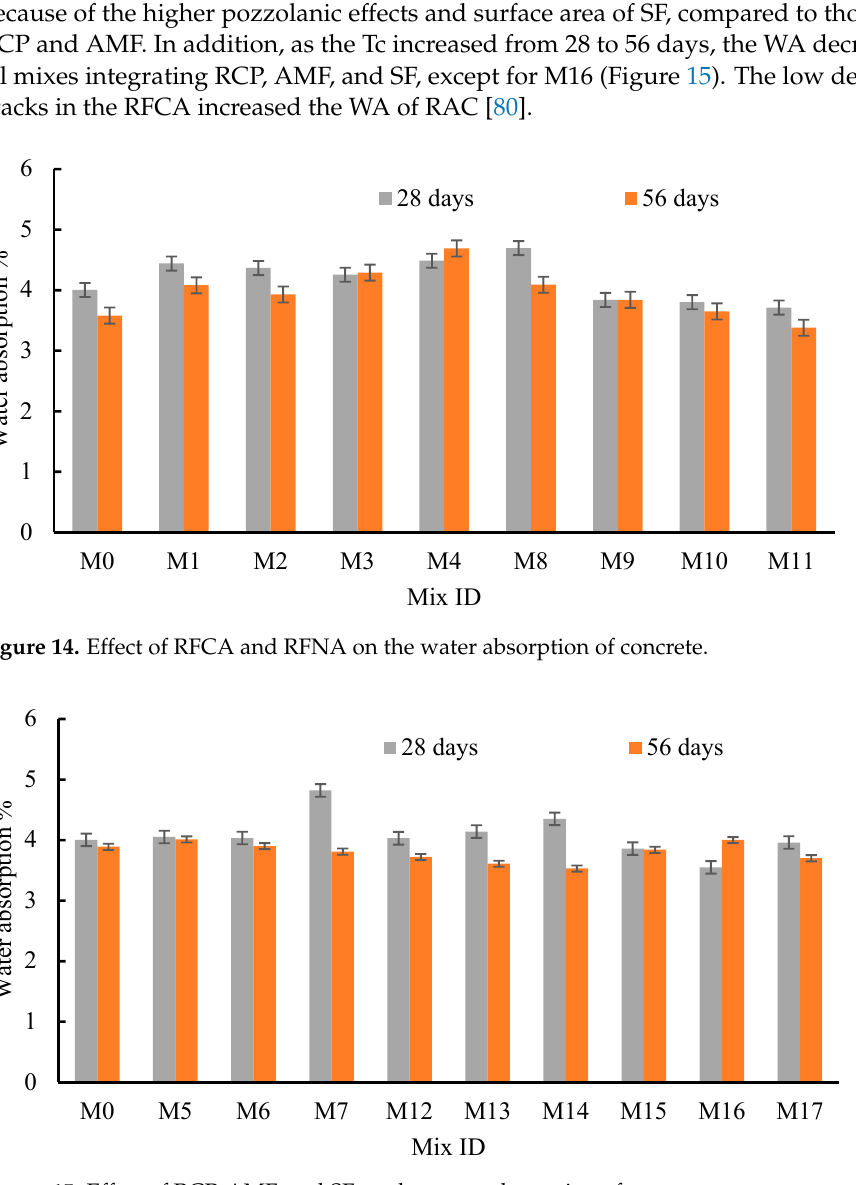
Figure 15. Effect of RCP, AMF, and SF on the water absorption of concrete.